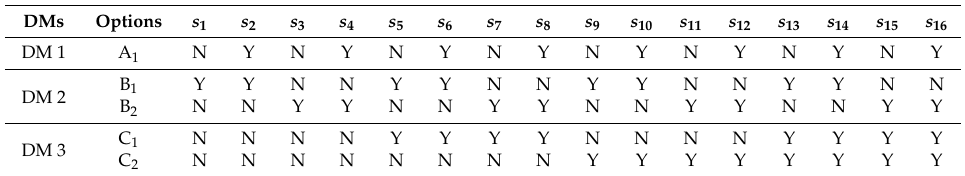
Table 4. Feasible